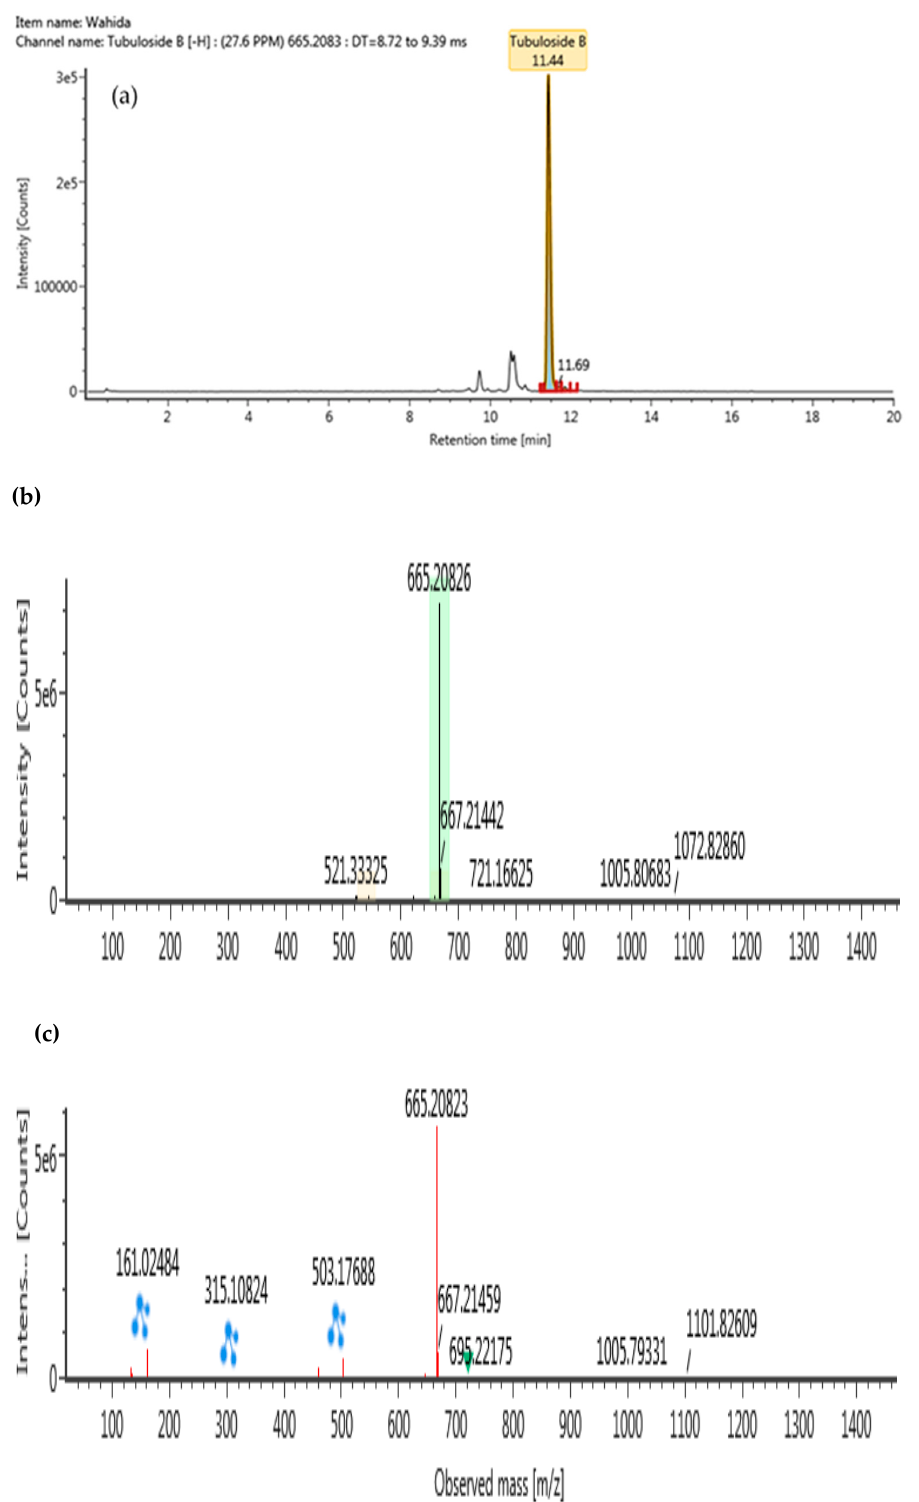
Figure 8. UHPLC ‐ QTOF/MS chromatograms of tubuloside B from Barleria lupulina Lindl. leaf ex ‐ Figure 8. UHPLC-QTOF/MS chromatograms of tubuloside B from Barleria lupulina Lindl. leaf extract (BLLE): ( a ) chro- tract (BLLE): ( a ) chromatogram mass spectrum; ( b ) low energy of mass spectrum; ( c ) high energy matogram mass spectrum; ( b ) low energy of mass spectrum; ( c ) high energy of mass of mass spectrum.